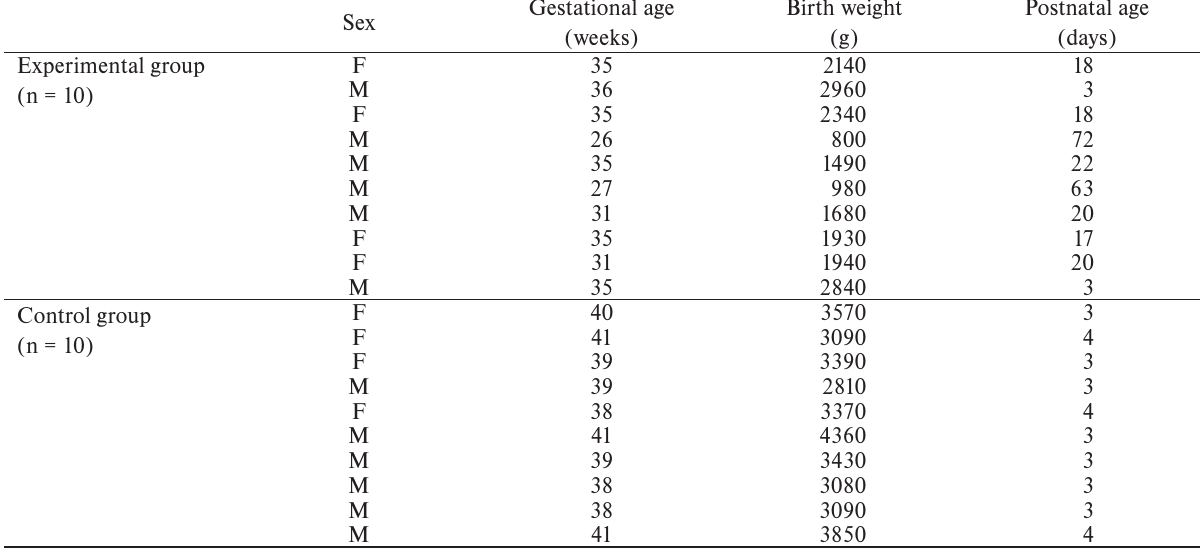
Table 1. Experimental and control group